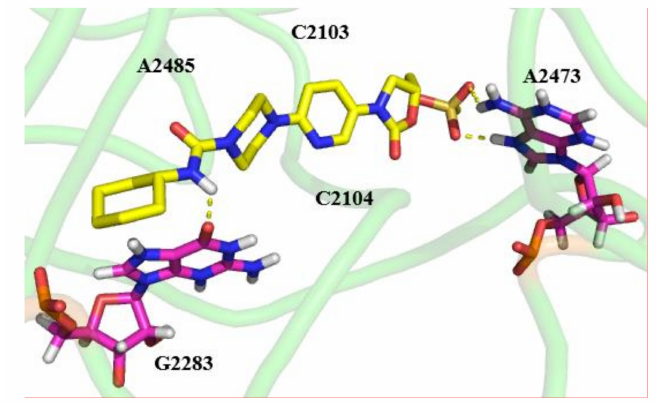
Figure 5. Binding mode of compound 12e to the ribosomal subunit